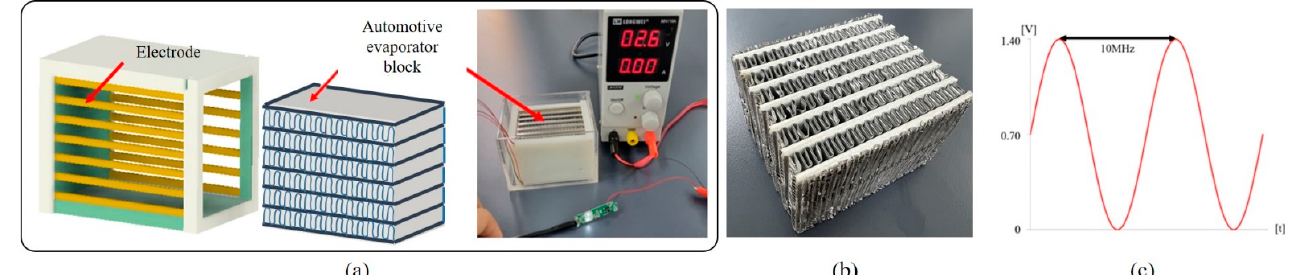
Figure 3. ( a ) Schematic of the testing package and photo of the biofilm growth testing setup and the power supply, ( b ) a real evaporator block taken from a new automotive part for biofilm growth testing (7 cm × 6 cm × 4.5 cm, Elantra, Hyundai Motors Korea), ( c ) signal from the electronics for biofilm reduction. Table 1. Summary of the testing package and analysis method.